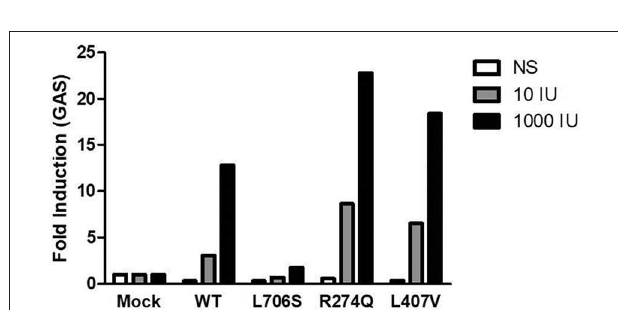
FIGURE 4 | Fold induction of γ -activated sequence (GAS)-dependent reporter gene transcription activity was assayed after stimulation with 10 IU/ml or 1,000 IU/ml IFN- γ . The R274Q allele used as positive control, the L706S allele as negative control, and the L407V as a new mutant allele were transfected to U3C cells. The data represent 2 independent experiments performed in